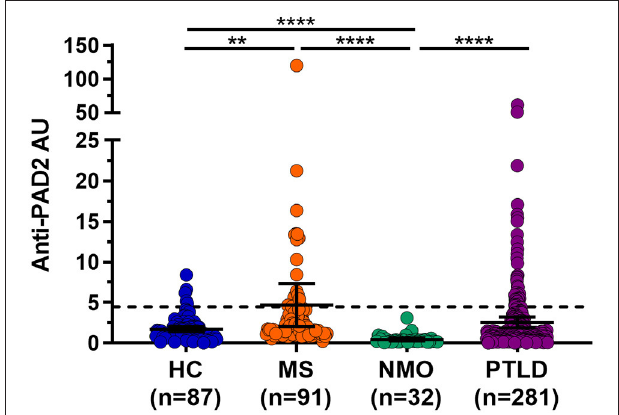
FIGURE 2 | Anti-PAD2 antibody levels in all patient groups. Anti-PAD2 Arbitrary Units (AU) for healthy controls (HC; n = 87) or people with multiple sclerosis (MS; n = 91), neuromyelitis optica (NMO; n = 32), and post-treatment Lyme disease syndrome (PTLD; n = 281) as measured by ELISA are shown. The dotted line represents the cutoff value for positivity at 4.5AU. The median and 95% confidence interval of each group are shown. ****Mann–Whitney p -value < 0.0001 and ** < 0.01.